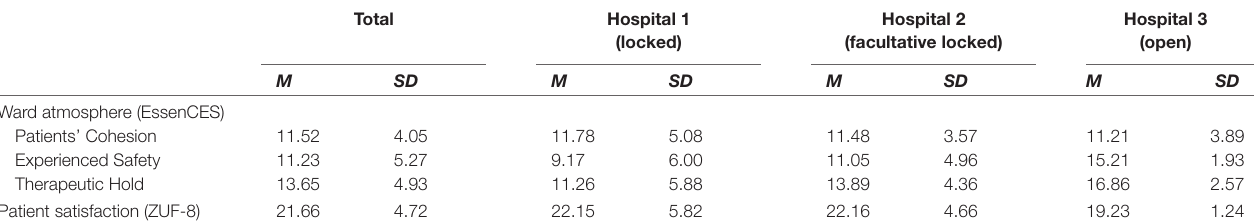
TABLE 3 | Ward atmosphere (EssenCES) and patient satisfaction (ZUF-8) in total and per